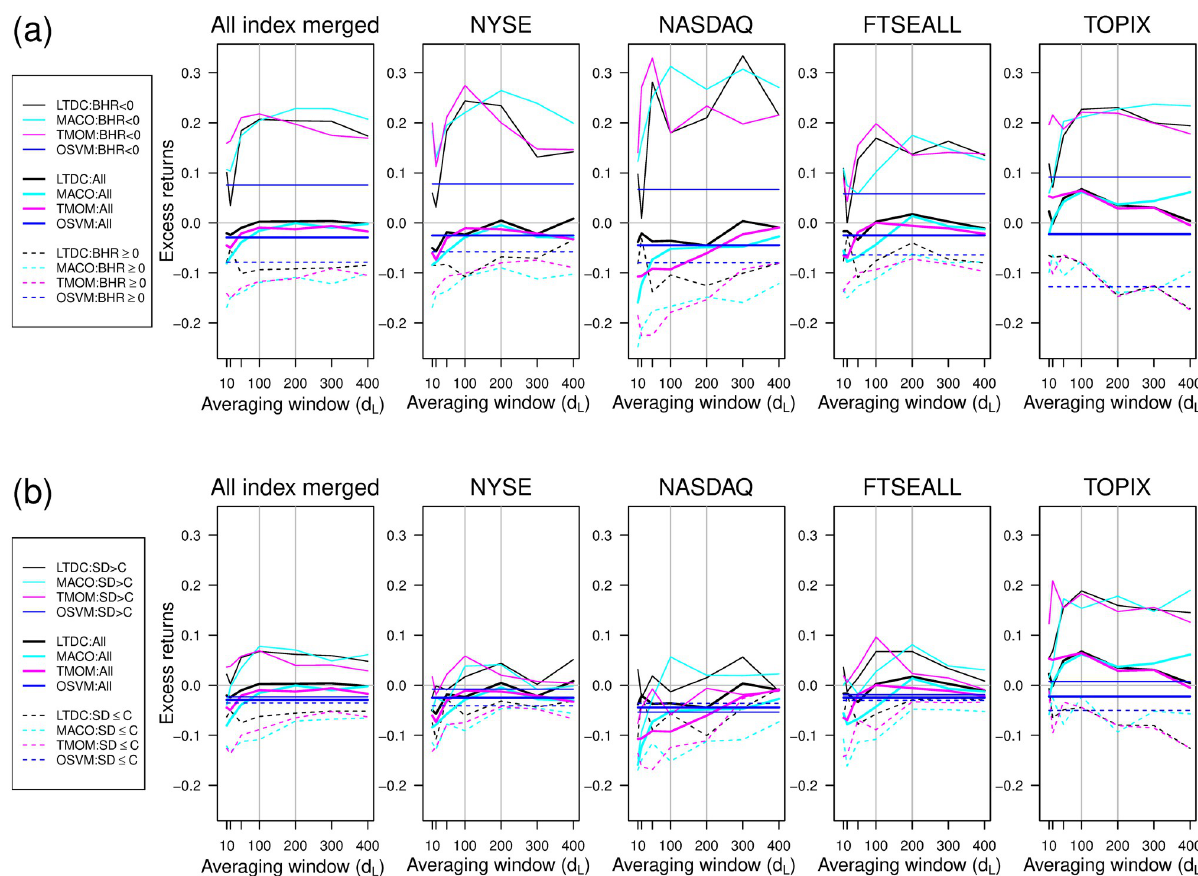
Fig 10. Changes in the relationship between annual excess returns and averaging window by market risk condition. (a)Risk phase by market trend direction; (b) Risk phase by market volatility